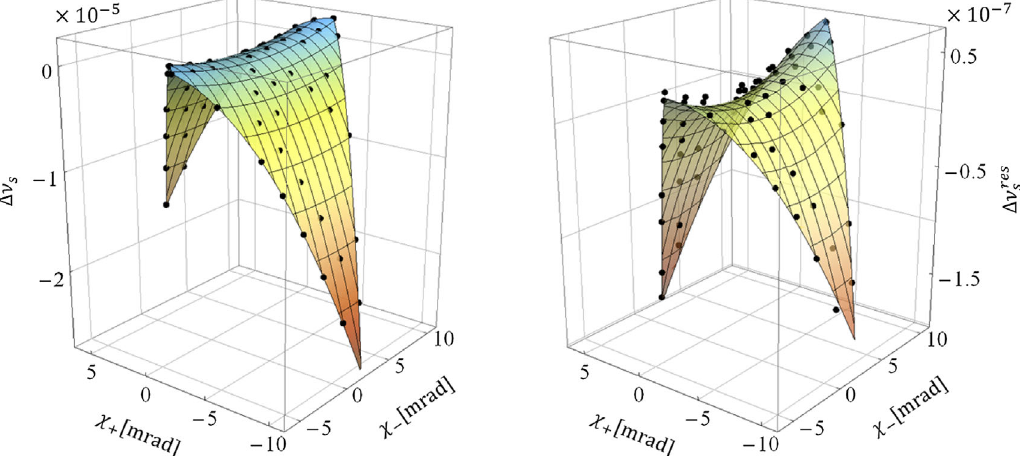
χ ; χ − Þ . Each point represents a single s ð þ Δ ν − Δ ν fit . As described in the text, using s ¼ s s